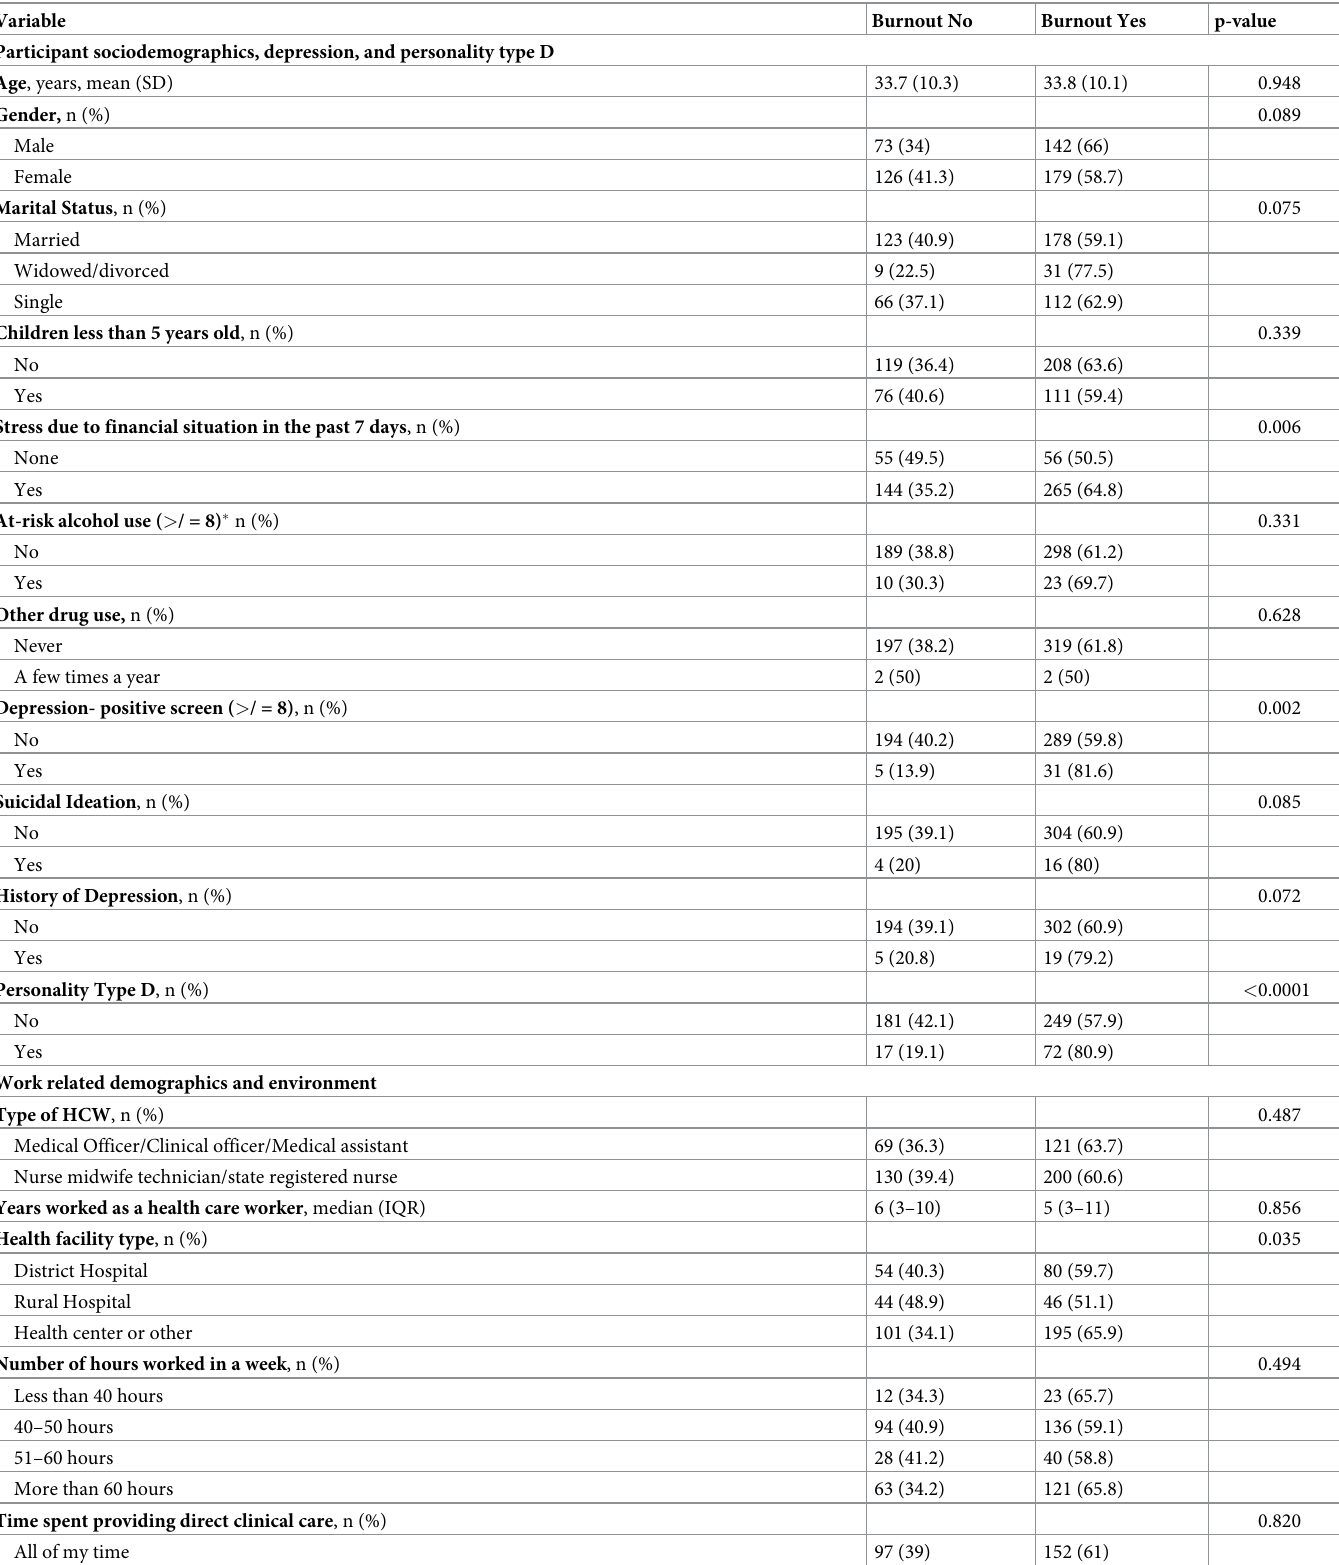
Table 1. Factors associated with burnout, univariable